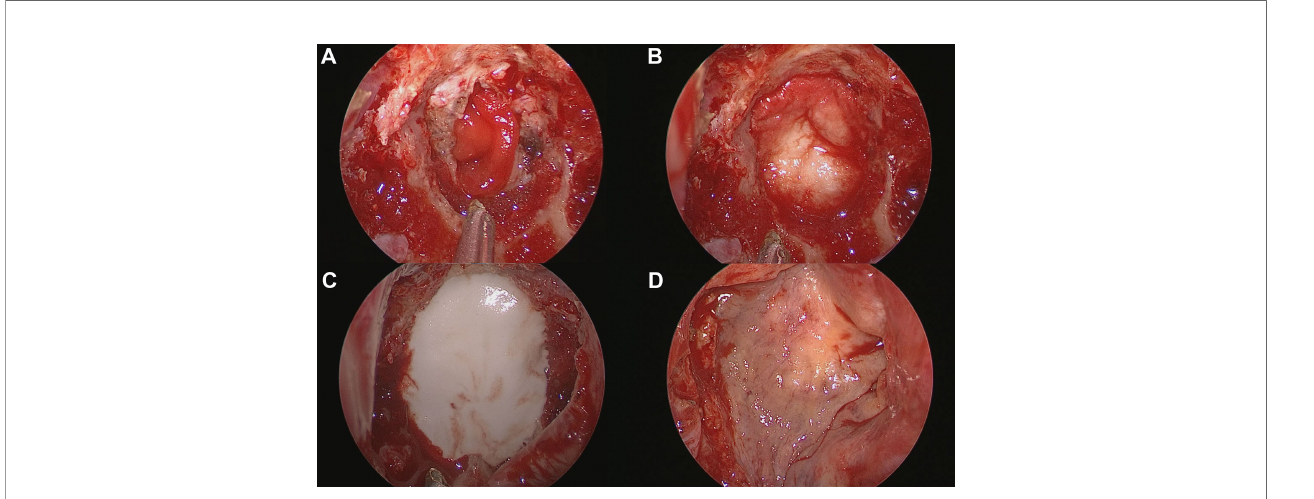
FIGURE 2 | Process of skull base reconstruction using a multilayer technique with hydroxyapatite and a naso-septal fl ap. (A) Collagen matrix placed into the arachnoid defect. (B) Acellular dermal graft laid over as an on-lay dura graft after being tailored according to the size of the bone defect. (C) Injectable hydroxyapatite was applied as an additional closure of the sellar defect. (D) A naso-septal fl ap covers the above